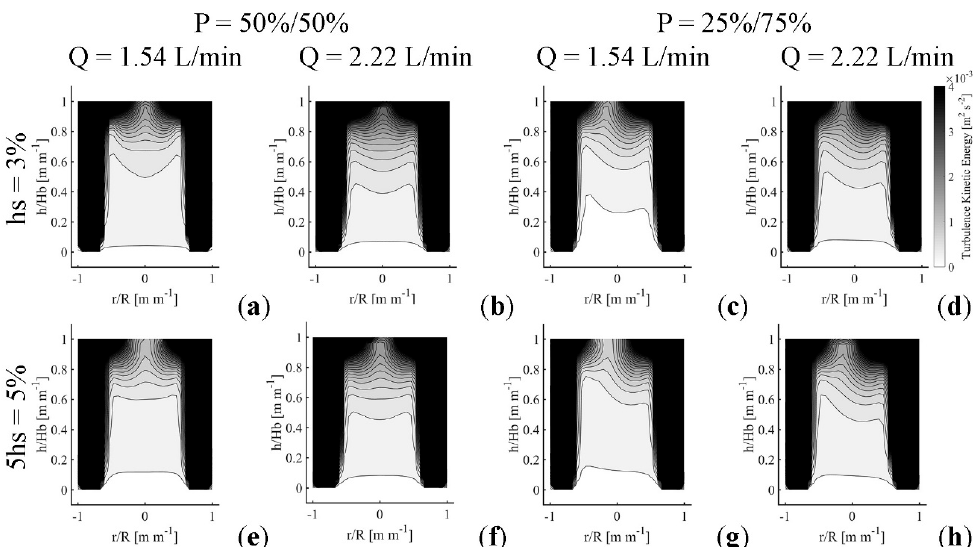
Figure 6. Contours of turbulent kinetic energy ( k ) of the eight case studies obtained with the numerical model and shown along the same longitudinal plane. ( a ) through ( h ) are the experiments described in Table 2. The cases presented in this study are in the same order as in the experimental study of Jardón-Pérez et al. [15] . Table 3. Mean values of velocity v (× 10 − 2 m/s) for the experimental and numerical model along the longitudinal plane (symmetry plane) for the eight cases presented in this study.